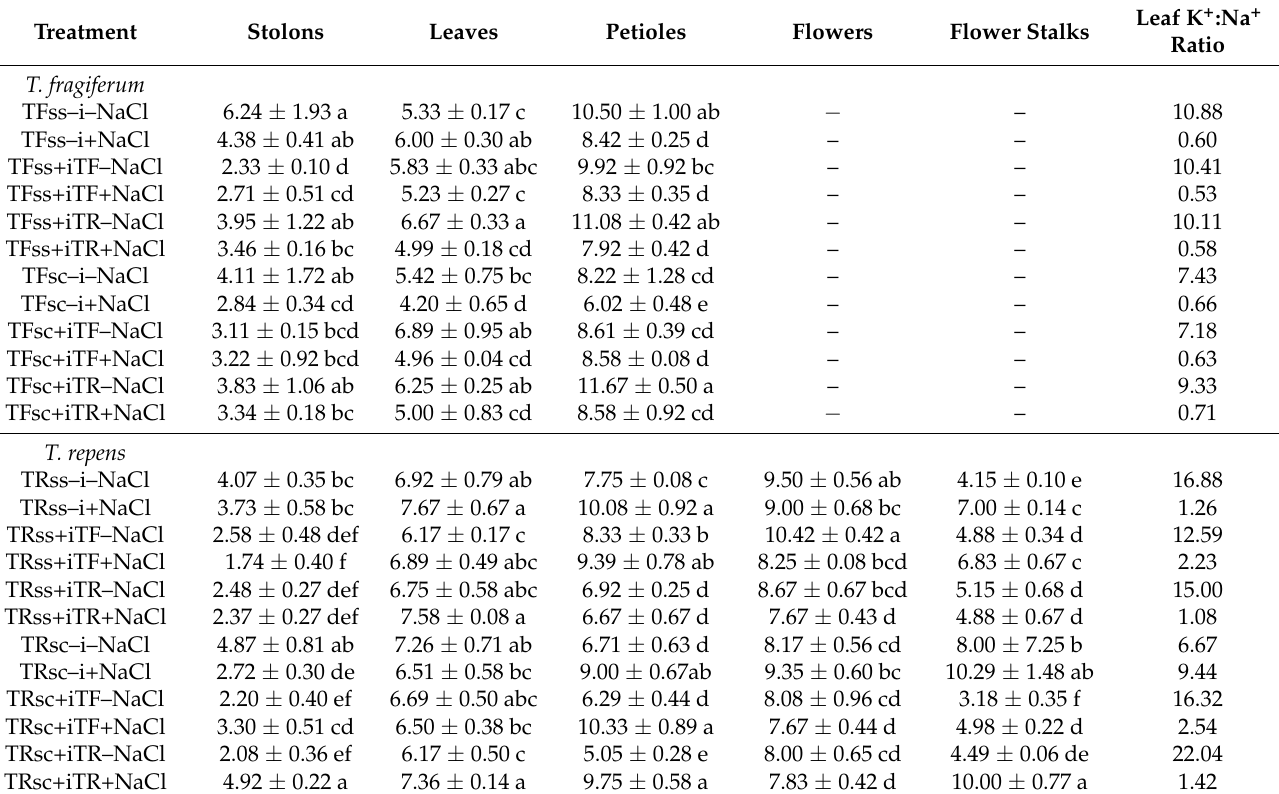
Table 11. Tissue K + concentration (g kg − 1 DM) in different parts of T. fragiferum and T. repens at the harvest and leaf K + /Na + concentration ratio.